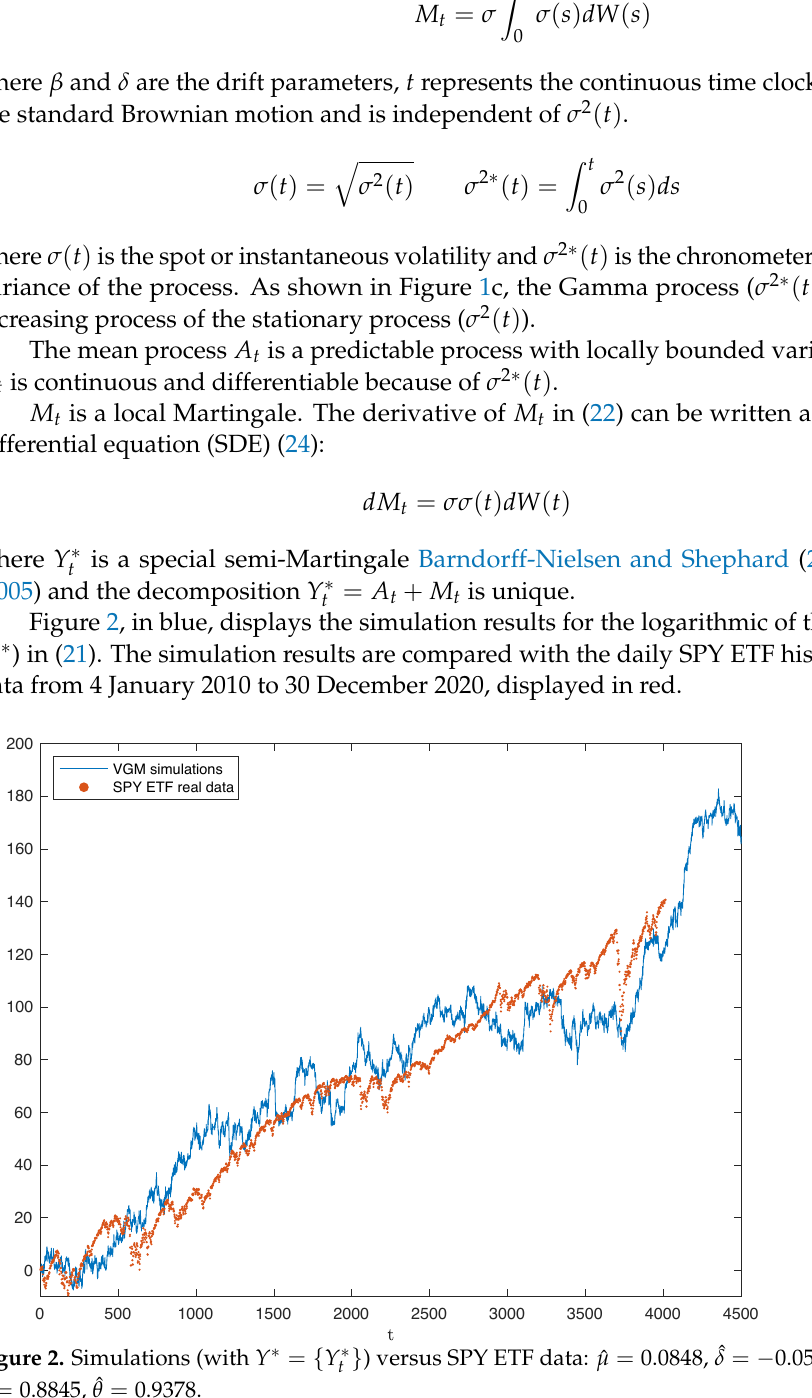
Figure 2. Simulations (with Y ∗ = { Y ∗ ˆ α = 0.8845, ˆ θ =